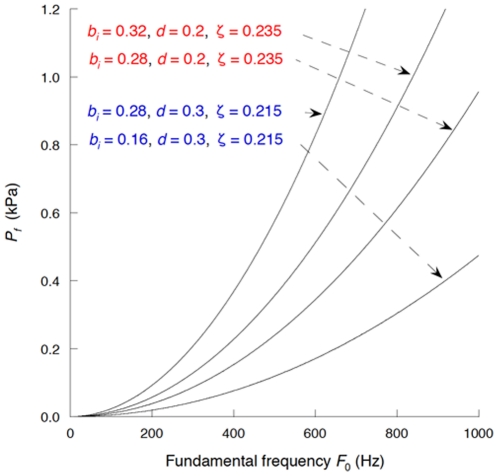
The effect of vocal fundamental frequency F
0 on Pf.